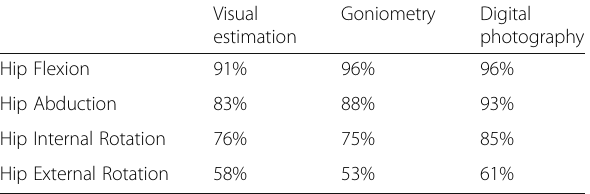
Table 2 Precision by technique for hip range of motion (proportions of measurement errors within 10° of motion capture analysis)